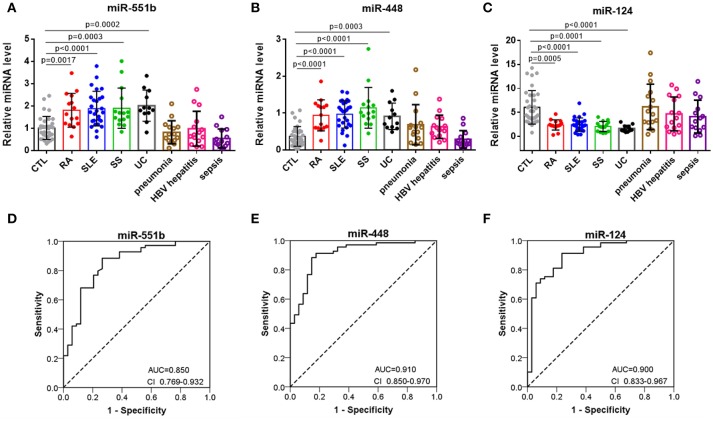
Separation of patients with autoimmune diseases from controls by miR-551b, miR-448, and miR-124. (A–C) The relative expressions of 3 miRNAs were studied in serum from 34 healthy controls, 15 RA patients, 27 SLE patients, 15 SS patients, 12 UC patients, 15 pneumonia patients, 15 HBV hepatitis patients, and 14 sepsis patients. (D–F) ROC curves for the ability of miR-551b, miR-448, and miR-124 to separate patients with autoimmune diseases from controls. All the values are shown as the mean ± SEM.